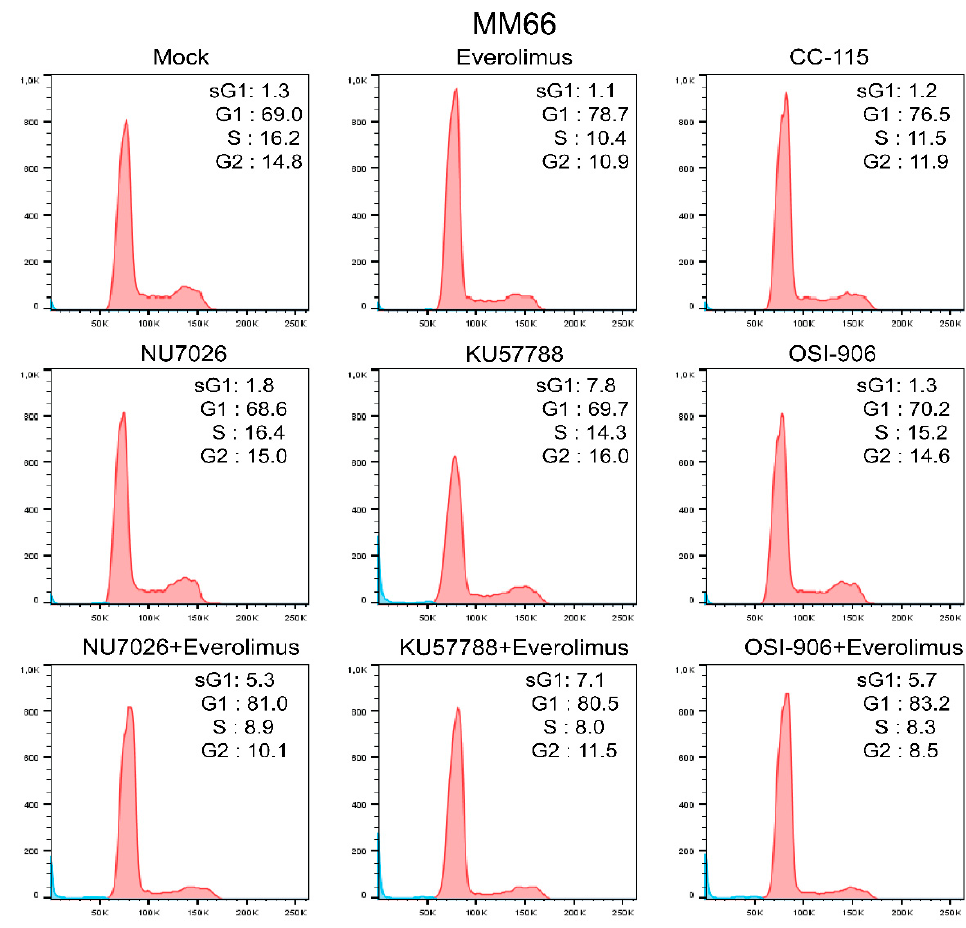
Figure 5. Treatment with everolimus (10 nM) alone or in combination with NU7036 (10 µM), KU57788 (2 µM), or OSI-906 (3 µM) for 5 days induced cell cycle arrest in G1 phase of MM66 cell line. Monotreatment with NU7026, KU57788, or OSI-906 did not affect cell cycle profile. Treatment with CC-115 (300 nM) induced G1 arrest. The number of cells in subG1 (sG1) subset marginally increased upon the treatments.